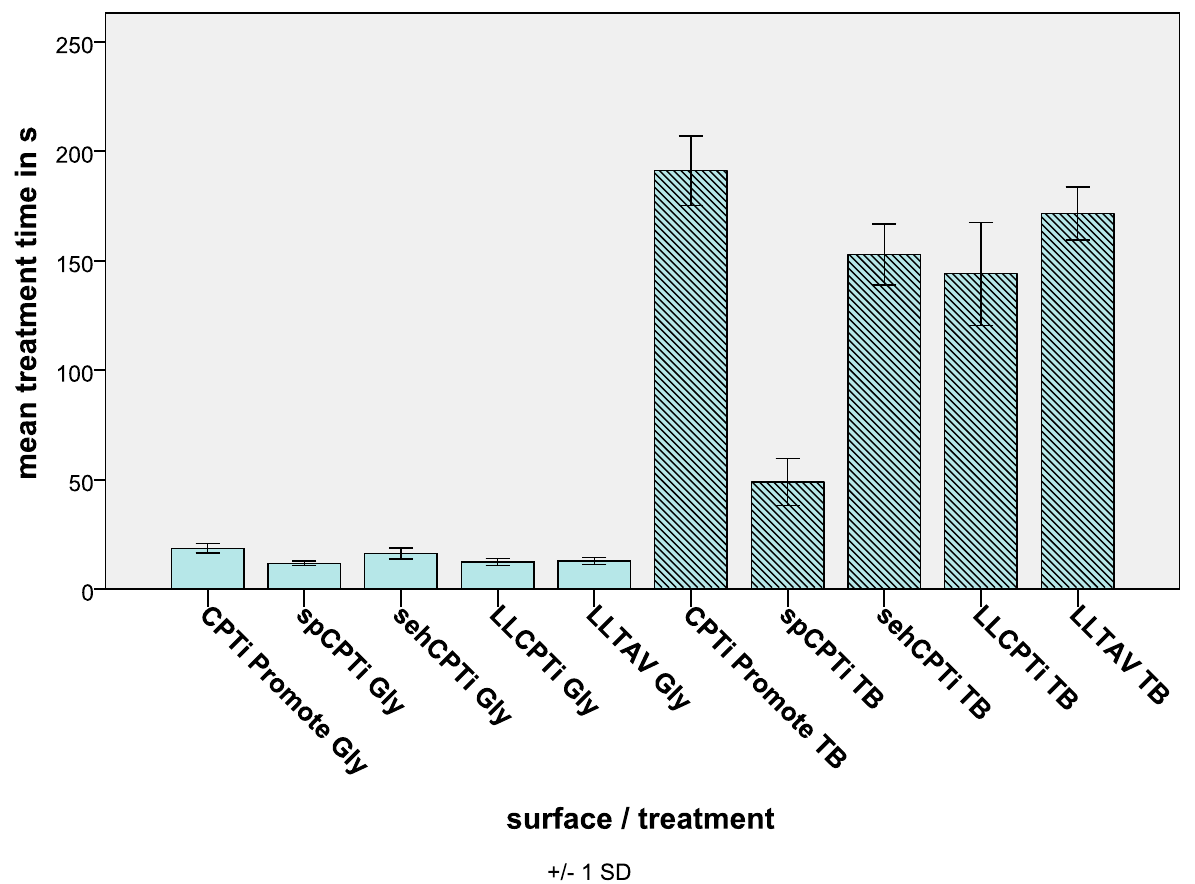
Fig. 2 Overview of treatment times, required to remove biofilm macroscopically via toothbrushing (TB) or air abrasive device (Gly) regarding the groups. spCPTi, smooth pickled titanium; sehCPTi, hydrophilic smooth and acid-etched titanium; CPTi Promote, titanium Promote; LL CPTi, Laser- Lok titanium; LL TAV, Laser-Lok titanium aluminium